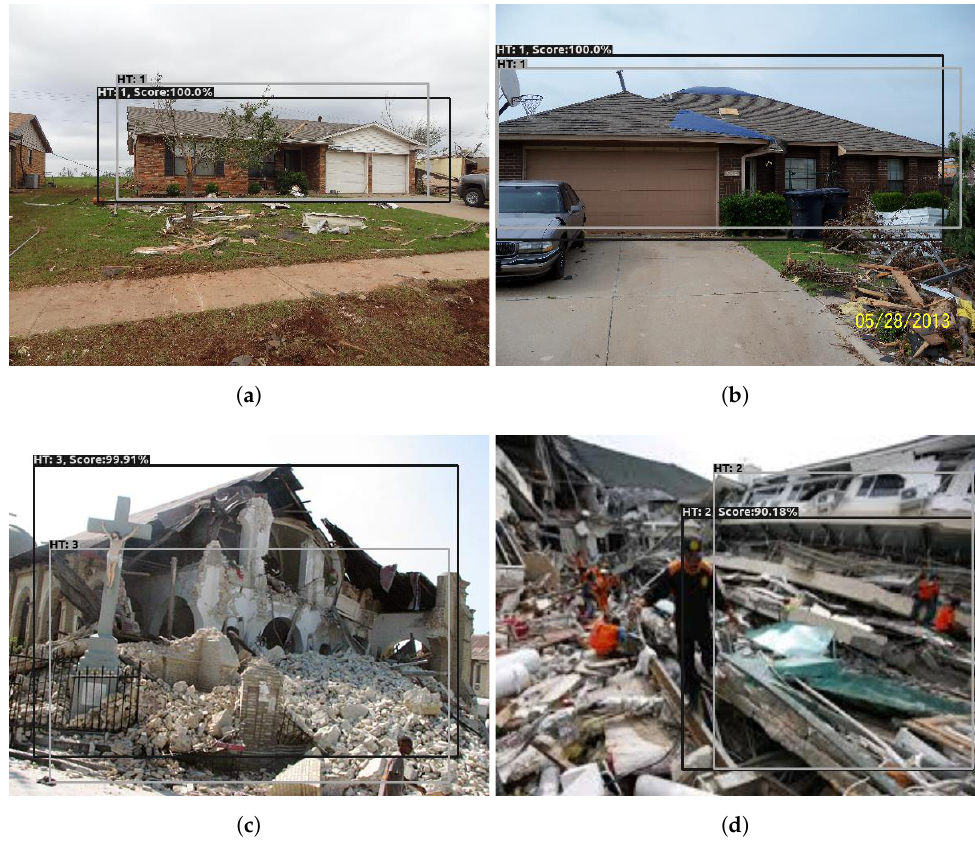
Figure 7. Hazard-type prediction using M HT ( FRC , RN ) (red-bounding boxes from prediction; and blue boxes from testing data): ( a ) Tornado-wind scene (correct prediction with a score of 100.0%); ( b ) Tornado-wind scene (correct prediction with a score of 100.0%); ( c ) Earthquake-shaking scene (correct prediction with a score of 99.9%); ( d ) Tsunami-wave scene (correct prediction scene with a score of